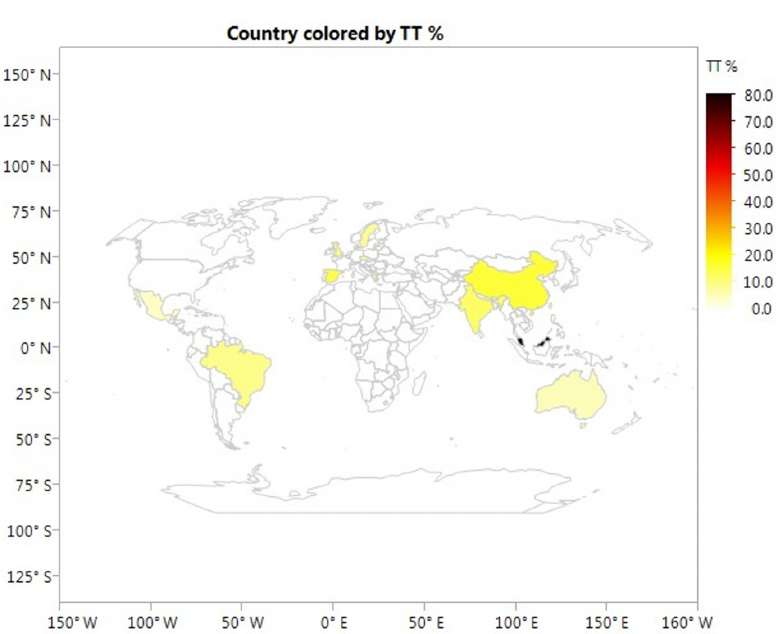
Fig 4. Geographic distribution of risk TT allele of rs7903146 polymorphism stratified by study country. The color bar on the right corresponds to the respective allele frequency map (10% interval). This global map showing geographical distributions of the risk T allele frequency was generated using JMP Statistical Discovery software (Version 12 SAS institute Inc., Cary, NC).